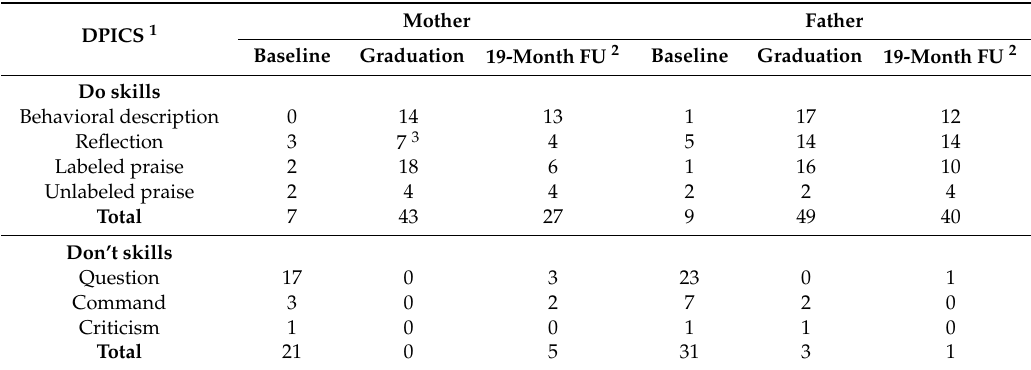
Don’t skills Question